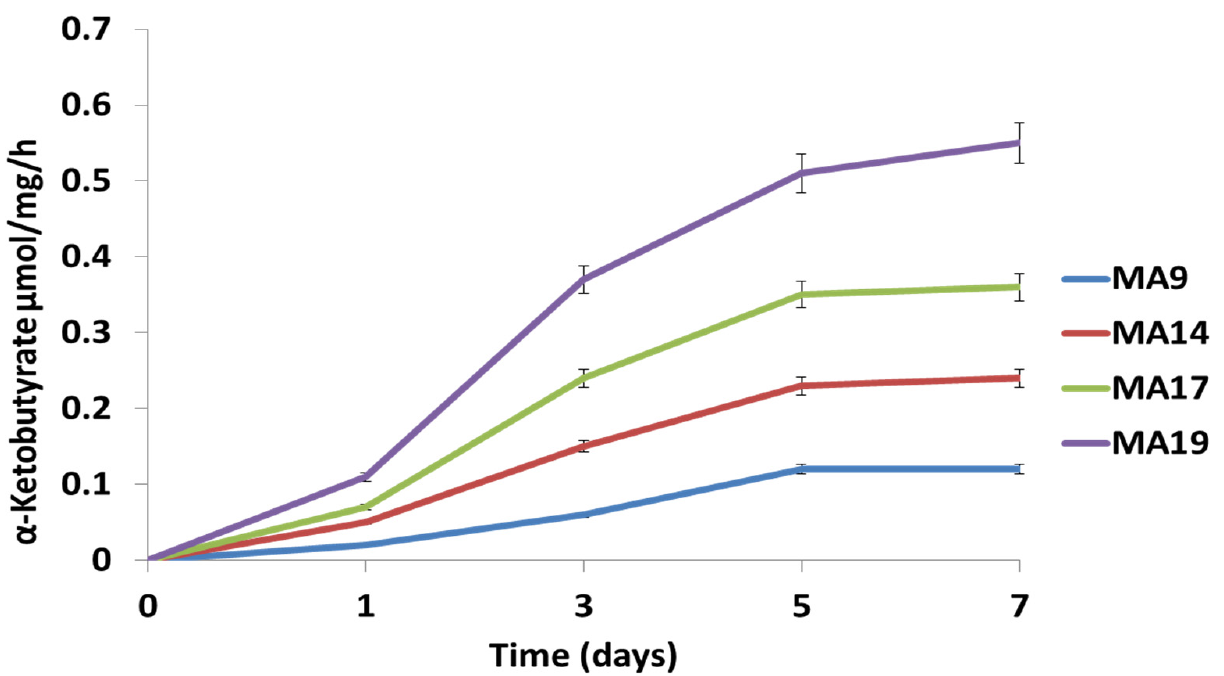
Figure 1. ACC deaminase activity expressed in µmol ketobutyrate mg − 1 h − 1 of selected endophytic bacteria on N-free medium (NFMM) supplemented with ACC (1-aminocyclopropane-1-carboxylate) as nitrogen source. Error bars show the standard deviation of the mean values of three replicates ( p < 0.05).